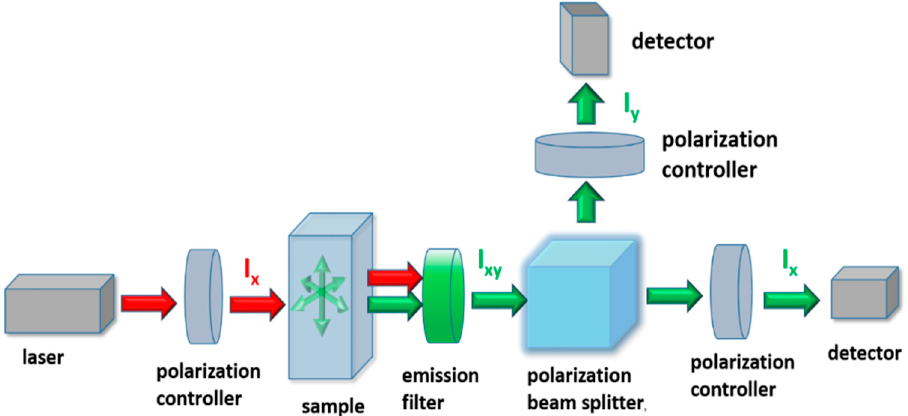
Figure 1. Typical setup for the fluorescence anisotropy measurement in a two channel configuration. The linear polarized excitation signal from the laser lights the sample. The fluorescence signal is selected by an emission filter, then two orthogonal states of polarization are separated using a polarization beam splitter and are measured simultaneously using two detectors.